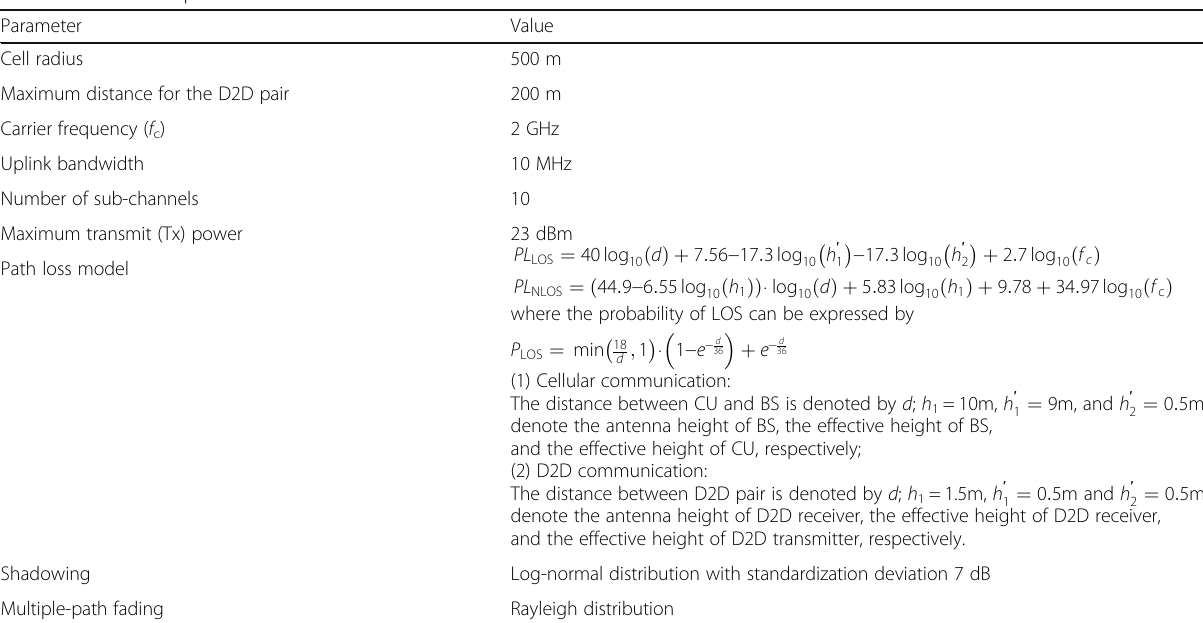
Table 1 Simulation parameters